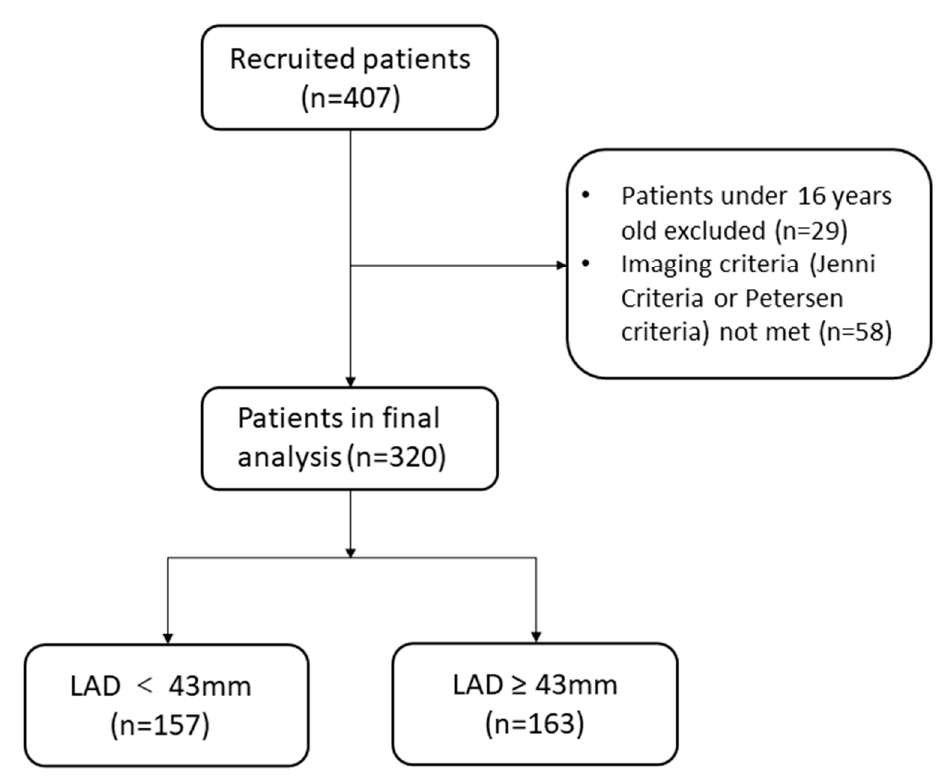
Figure 1. Flow chart of the study population. LAD, left atrial diameter.